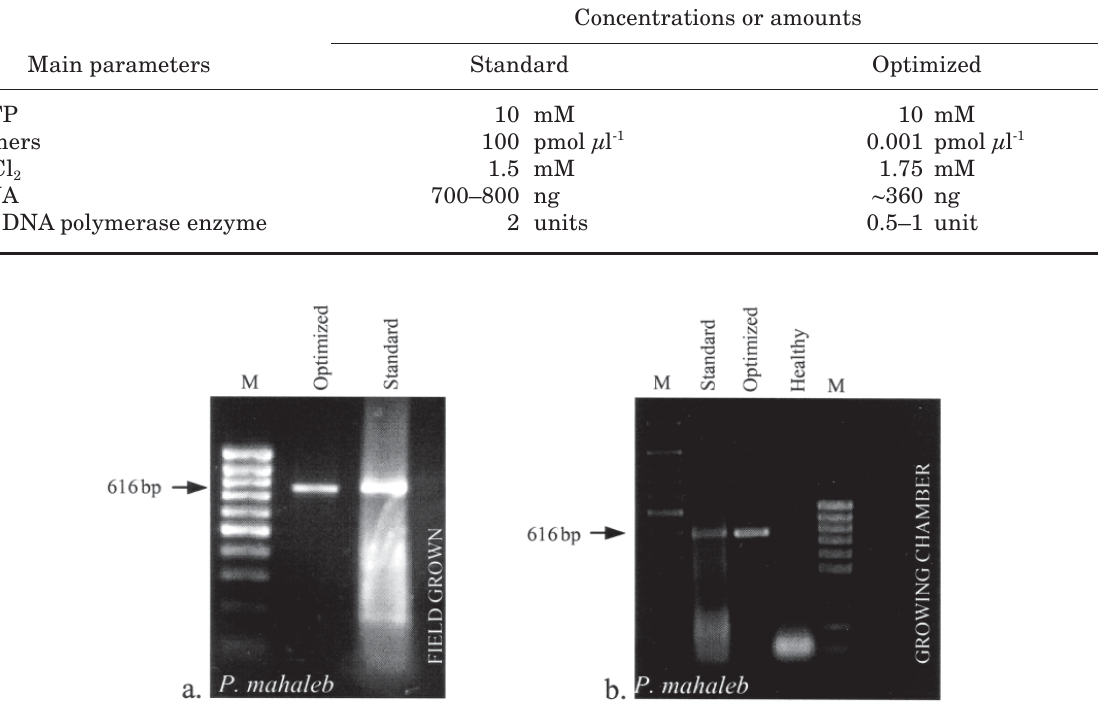
Fig. 4. Optimized PCR amplification to detect PNRSV from field (a) and growth-chamber (b) grown